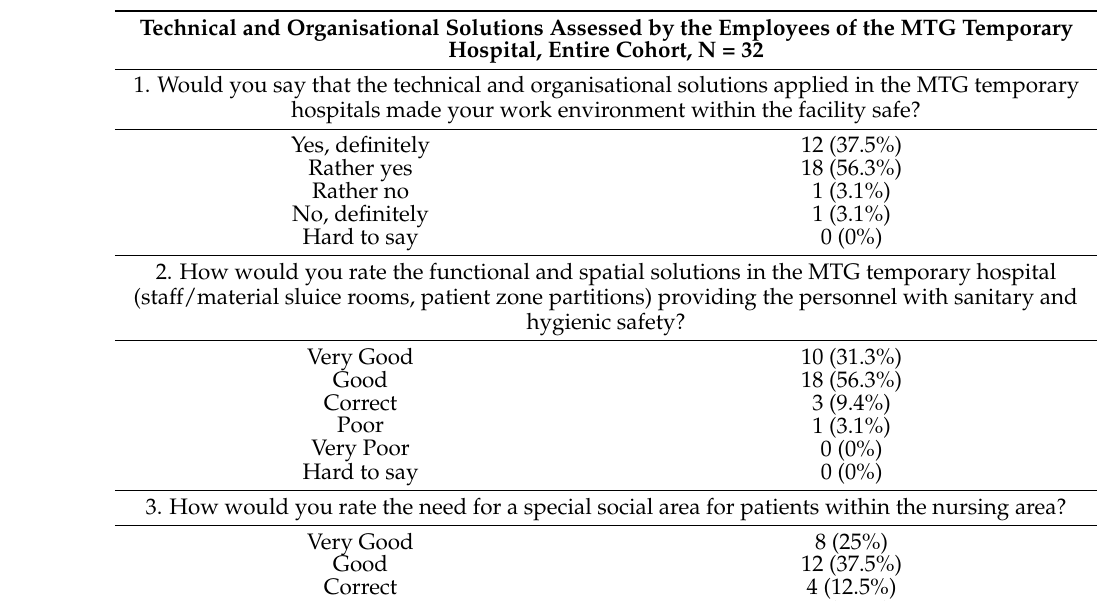
Table 2. Questionnaire-based survey related to assessing the technical and organisational solutions at the AmberExpo temporary